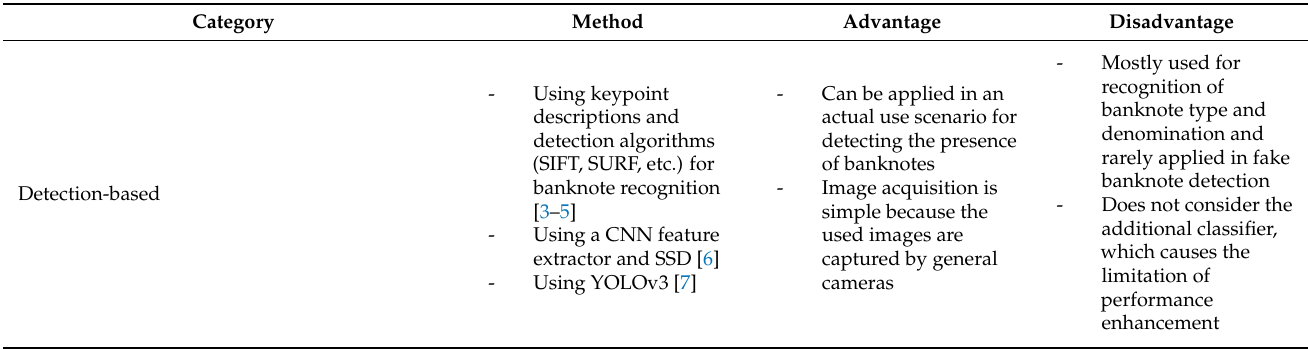
Table 1. Comparisons of previous studies and our proposed